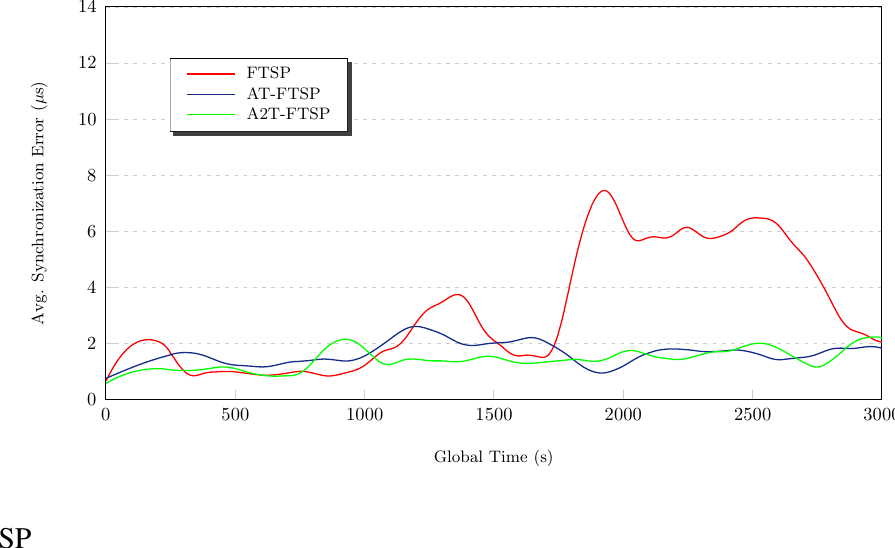
Figure 3. Behavior study: 9 ◦ C– 22 ◦